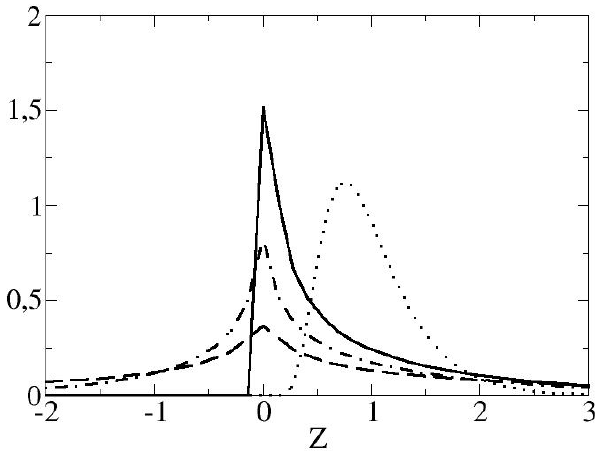
Figure 2. Probability density function of Z a / o ; ω (t) τ = 0, atmosphere full line, ocean dashed line, and for τ = 100, atmosphere dotted line, ocean dashed-dotted line. All are clearly non-Gaussian.